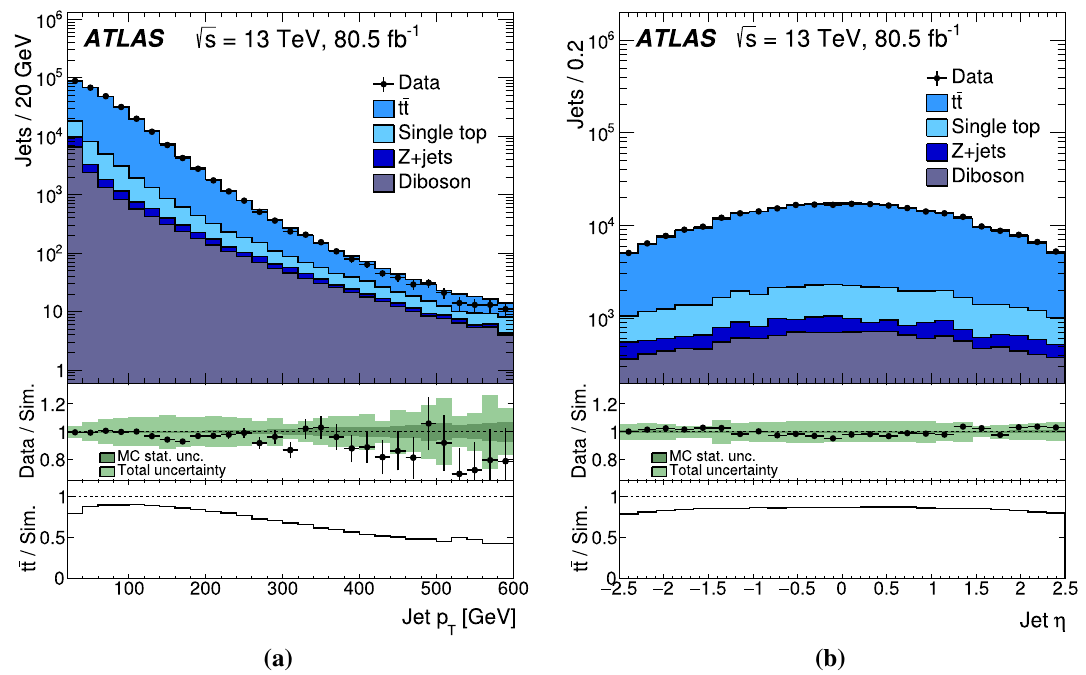
Fig. 3 Distribution of the jet ( a ) p T and ( b ) η in the events passing the selection. Simulated events are split into physics process. The ratio panels show the data-to-simulation ratio as well as the fraction of t ¯ t events among the simulated events